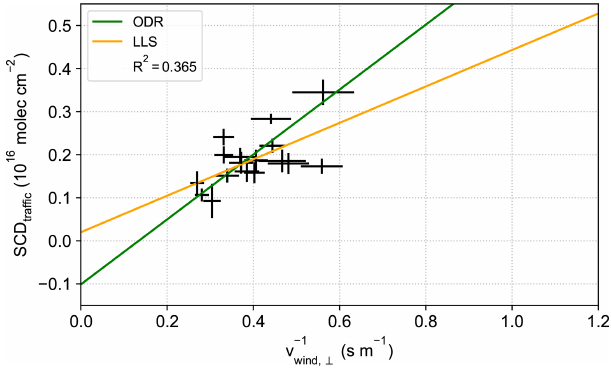
Figure B4. Correlation between the inverse of the wind velocity v − 1 instruments and the NO 2 signal (SCD traffic ) for a 12min averaging time span. The data points were fitted using the linear least squares (LLS) method and orthogonal distance regression (ODR).